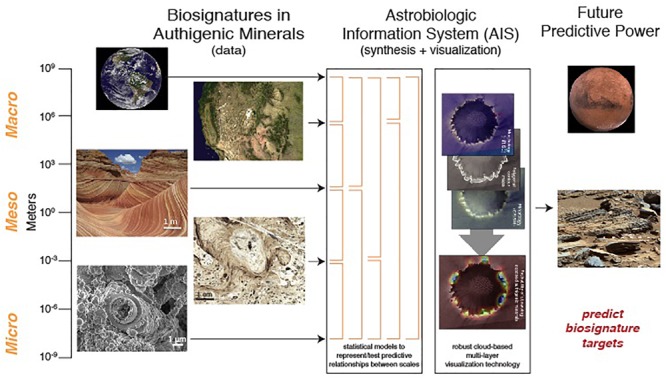
An integrative AIS looks toward predictive power for futures missions to map habitable environments and find the “sweet spots” of biosignatures through (1) the infusion of geologic and biologic characterizations at multiple scales with (2) statistical measures and a visualization platform.